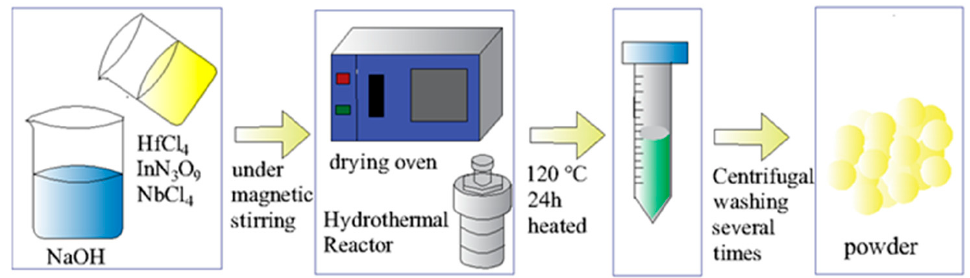
Figure 1. Hydrothermal route for the synthesis of HINO-0.005 powder.